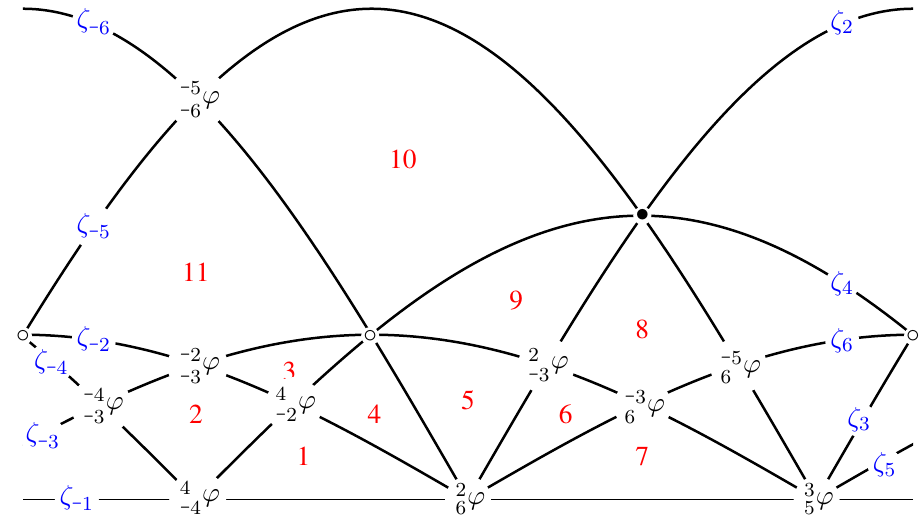
Fig. 11. The cylinder associated with ϑ 1 , when cut in two along the vertical plane θ = 0 , illustrates that the area calculation consists entirely of intersections of areas below a sine wave. The 11 areas numbered in red are the only ones for which the area needs to be calculated. The others follow by symmetry. Like in Figure 12, intersection points i j ϕ are labelled. To distinguish the labels from those used in Figure 12, the intersection is labelled using the indices of two of the arcs that cross ( ζ i , ζ j